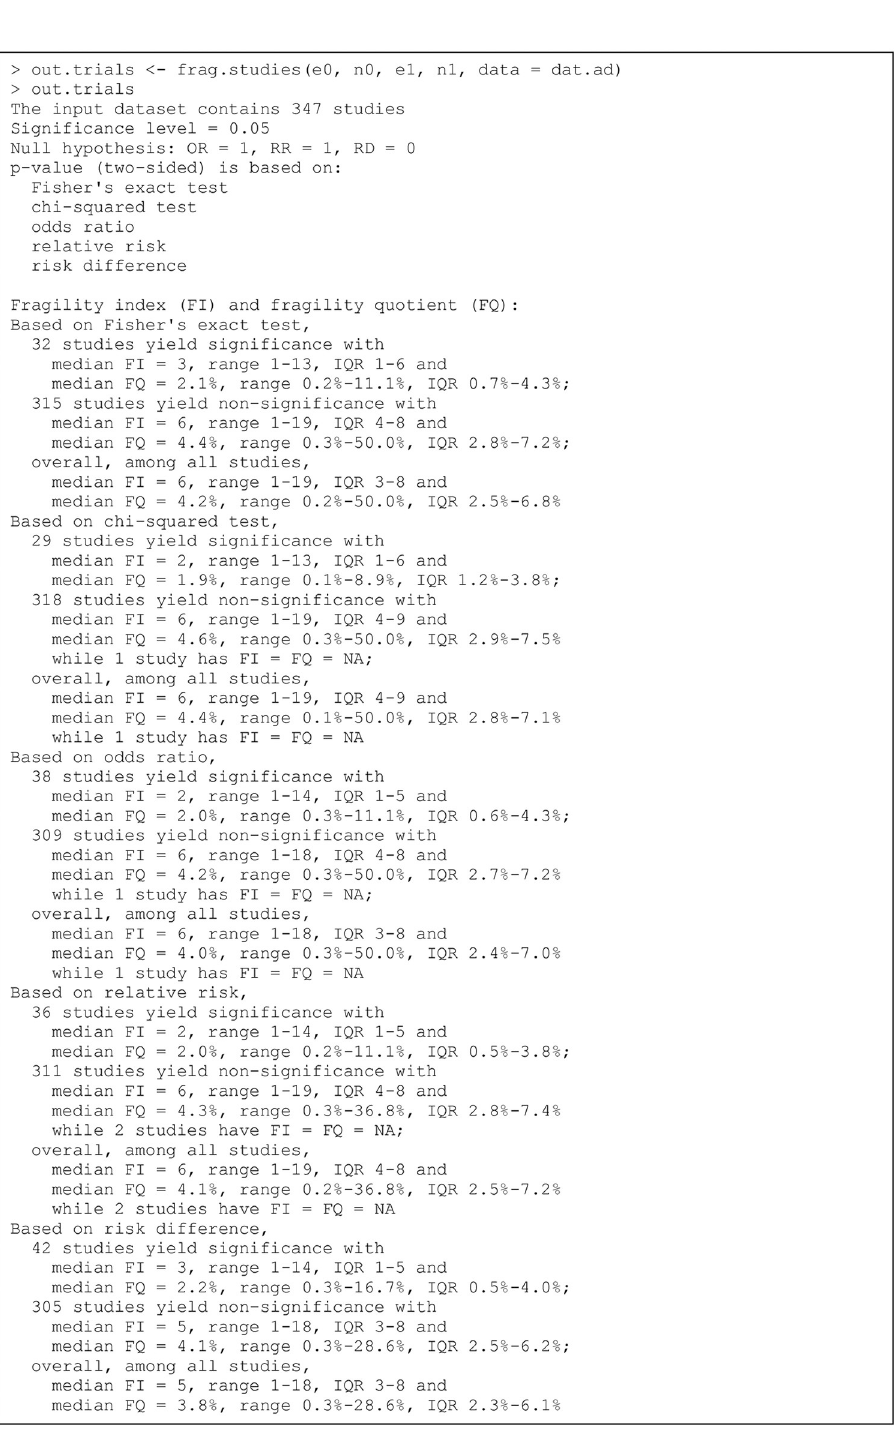
Fig 9. Output from the function frag.studies() .